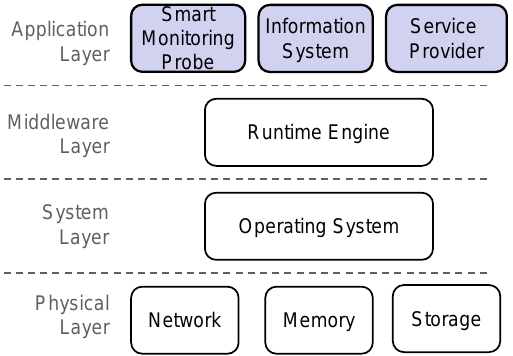
Figure 5. Software architecture of the smart monitoring probe.